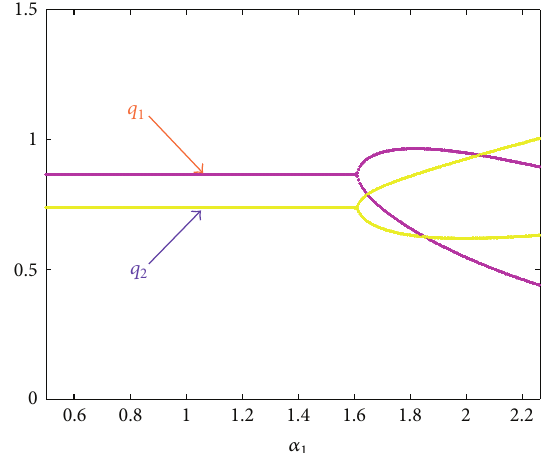
Figure 24: Bifurcation diagram of system (13) with 𝛼 1 ∈ = 1.46 and ] = 0.157 (0.5, 2.2622] , and 𝛼 2